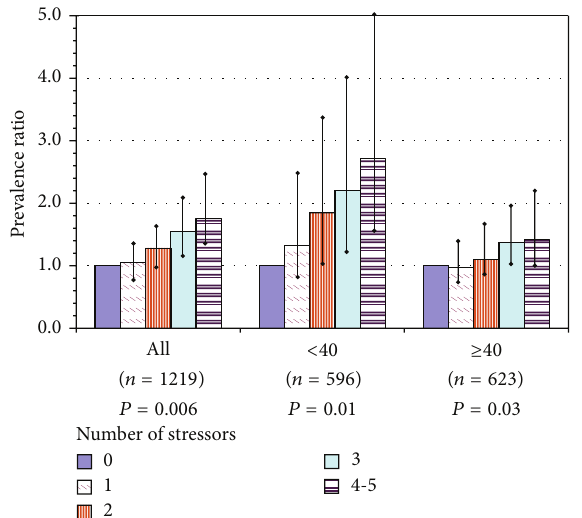
Figure 1: Overweight or obesity among U.S. nursing home employ- ees, as a function of number of workplace stressors in the current job, for all participants and by age group: prevalence ratios with 95% confidence intervals for each level above 0 stressors and 𝑃 value for test of linear trend. Index = sum of workplace stressors: poor coworker support, low decision latitude, recent assault(s) at work, work at night, and lifting heavy loads. Models adjusted for gender, education, and region; adjusted for age only in model of all workers.